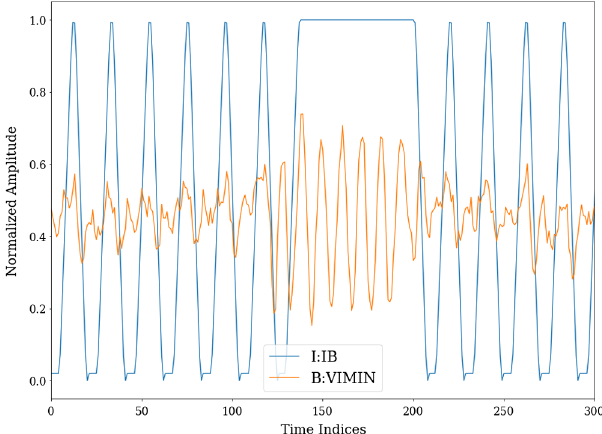
FIG. 3. Comparison between the main injector lower bend current and the compensated minimum GMPS current.